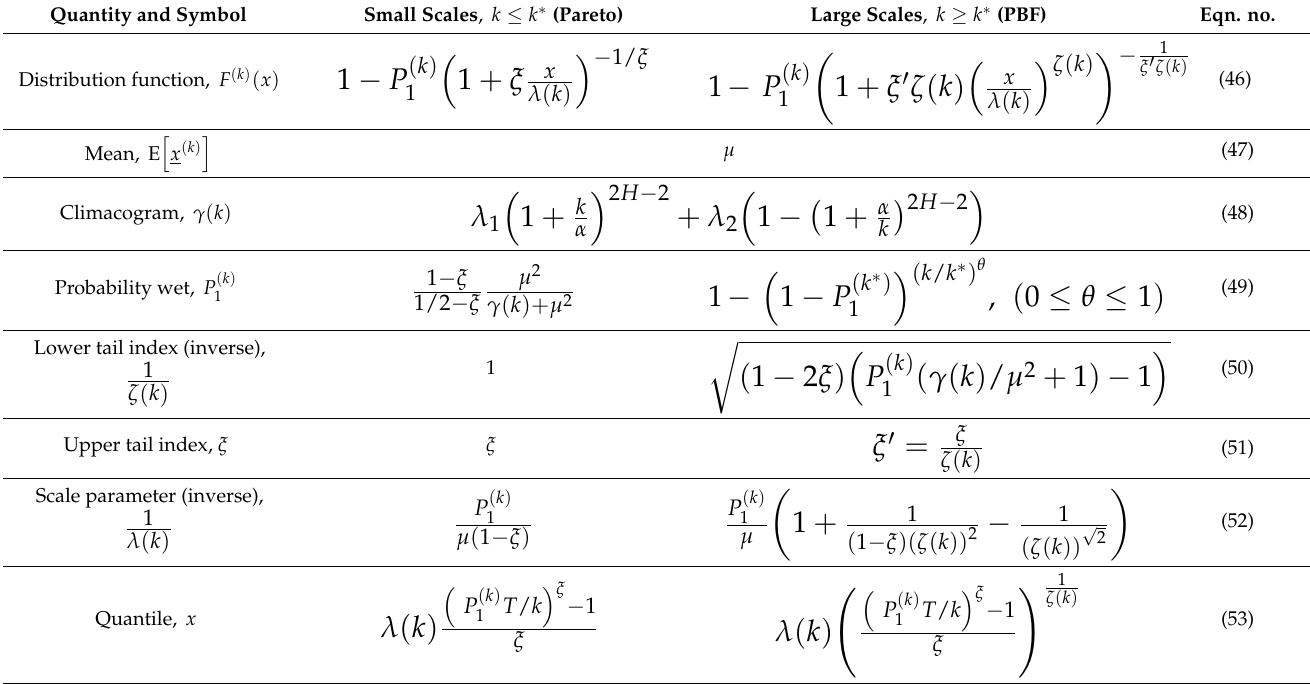
Table 5. Mathematical relationships of the ombrian model. The ombrian curves per se are given in the last row. Quantity and Symbol Small Scales , k ≤ k ∗ (Pareto) Large Scales , k ≥ k ∗